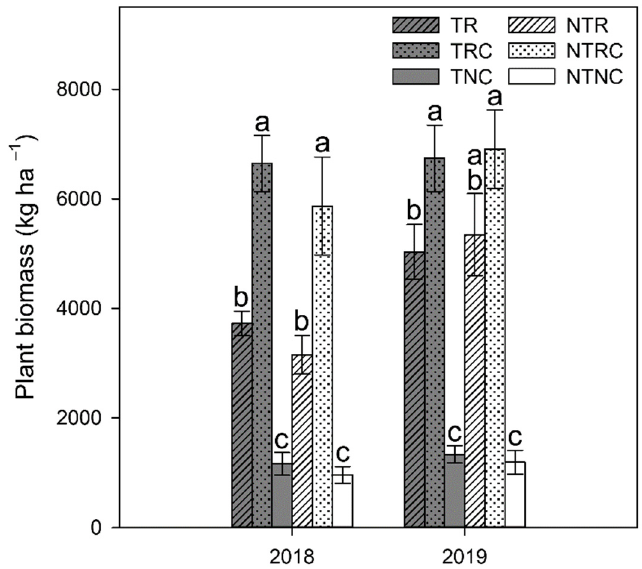
Figure 1. Plant biomass from winter growth in tilled (T) and no-till (NT) plots planted with rye only (R), rye plus crimson clover (RC), or no winter cover crop (NC) in April 2018 and 2019. Values represent the mean ± standard error. Statistical significance between treatments for each timepoint are denoted by different letters.